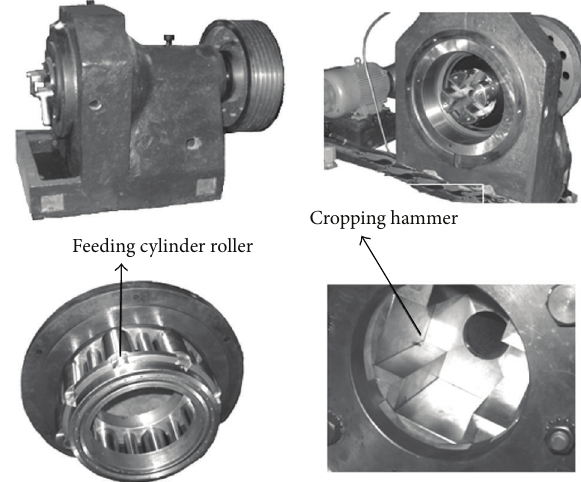
Figure 10: Photo of radial-forging cropping